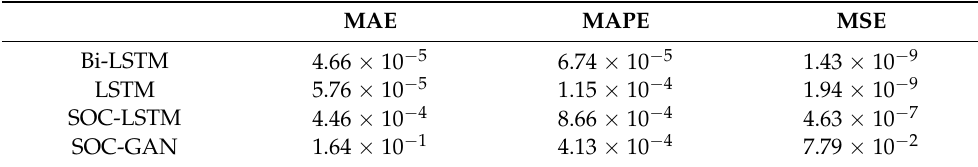
Table 6. Statistical indicator distributions for ship trajectory